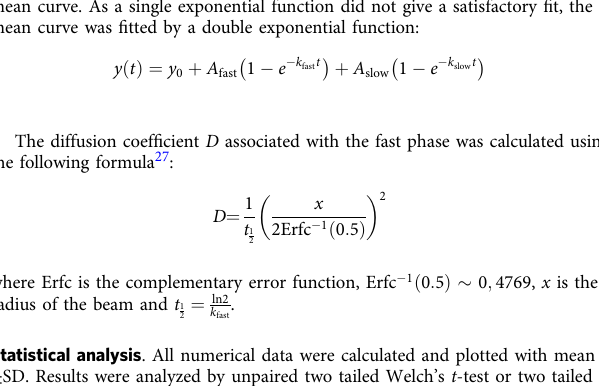
AxioObserver epi fl uorescence microscope (63× oil-immersion objective). Cells were maintained at 37 °C and 5% CO 2 during imaging. For live imaging of stress granules, U373-MG cells were transfected using Lipofectamine 2000 (Invitrogen) with a plasmid encoding a G3BP-GFP fusion protein prior to cell infection as previously described 20 .